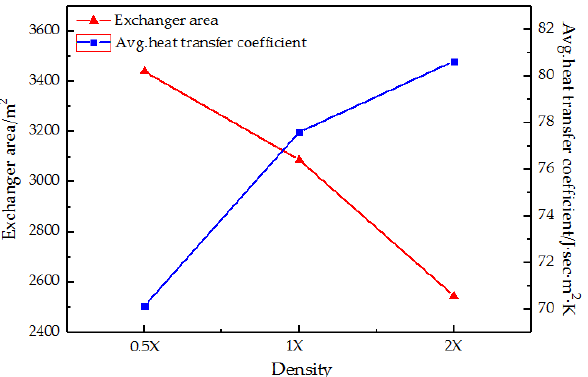
Figure 6. Effect of density of [emim][Tf 2 N] on the heat exchanger area and the average heat transfer coefficient of the heat exchanger. The red represents the exchanger area and the blue represents the average heat transfer coefficient.